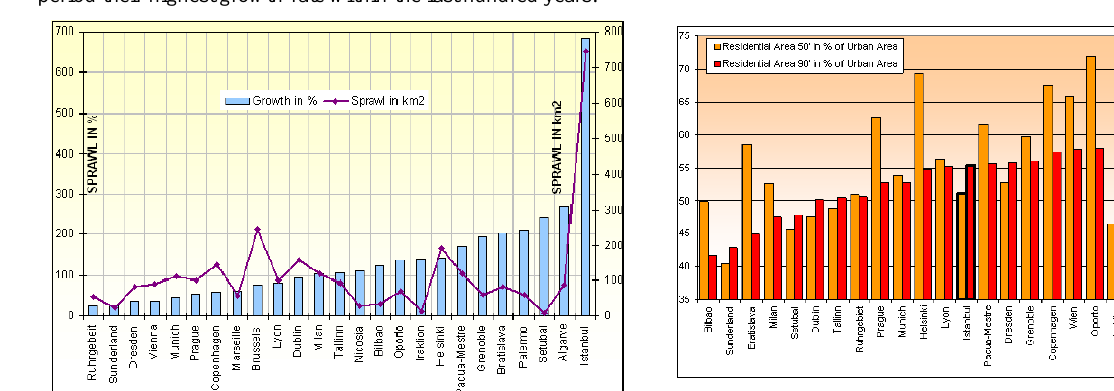
Figure 12: values on “MOLAND”-Cities for residential areas related to the urbanised